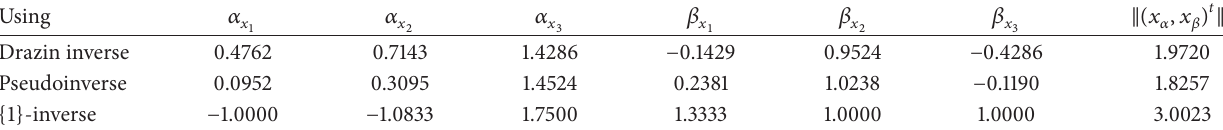
Table 4: Finding the left and right spreads.